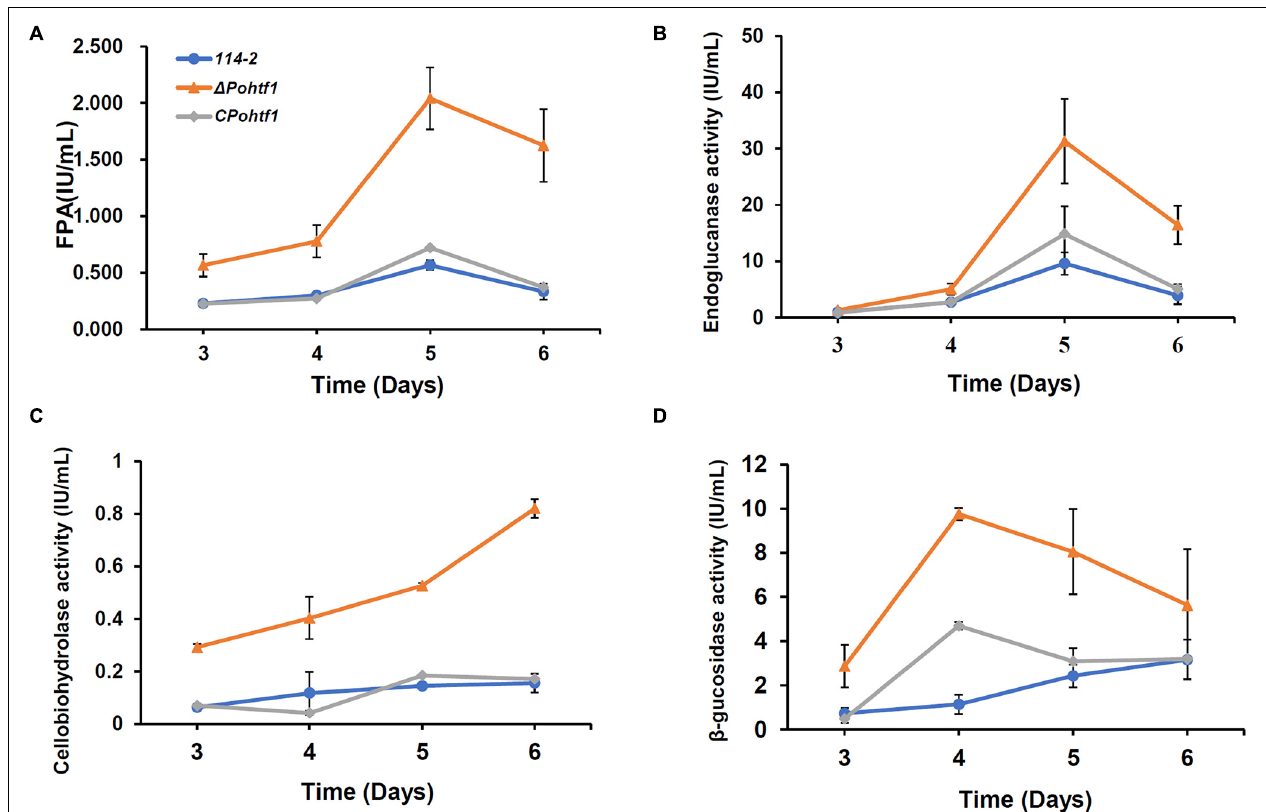
FIGURE 6 | Analysis of the cellulase activities of P. oxalicum 114-2, (cid:49) Pohtf1 and C Pohtf1 . (A) Filter Paper activity (FPA), (B) Endoglucanase, (C) Cellobiohydrolase and (D) β -glucosidase activities of strains P. oxalicum 114-2, (cid:49) Pohtf1 and C Pohtf1 were assessed. All the strains were sampled and measured every 24 h from day 3 to day